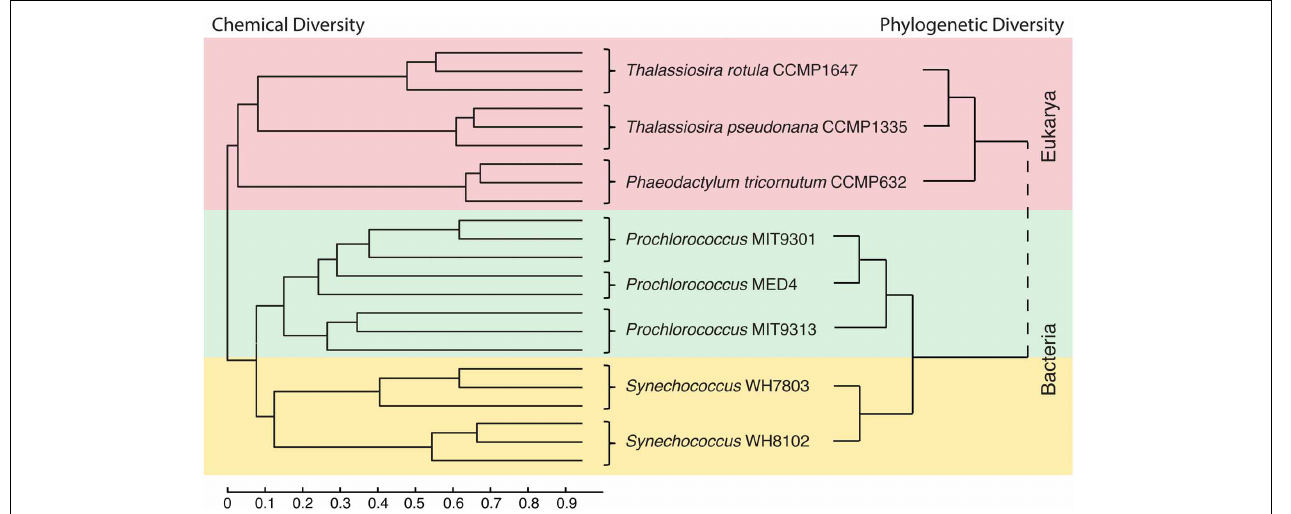
FIGURE 5 | Phylogeny of the eight model phytoplankton strains and the chemical similarity of the DOM they produce show similar relationship patterns. At left is shown a dendrogram created from the normalized similarity matrix of all DOM P features identified in each culture replicate after media subtraction using the unweighted pair group method average (UPGMA). The scale bar corresponds to percent similarity values of DOM